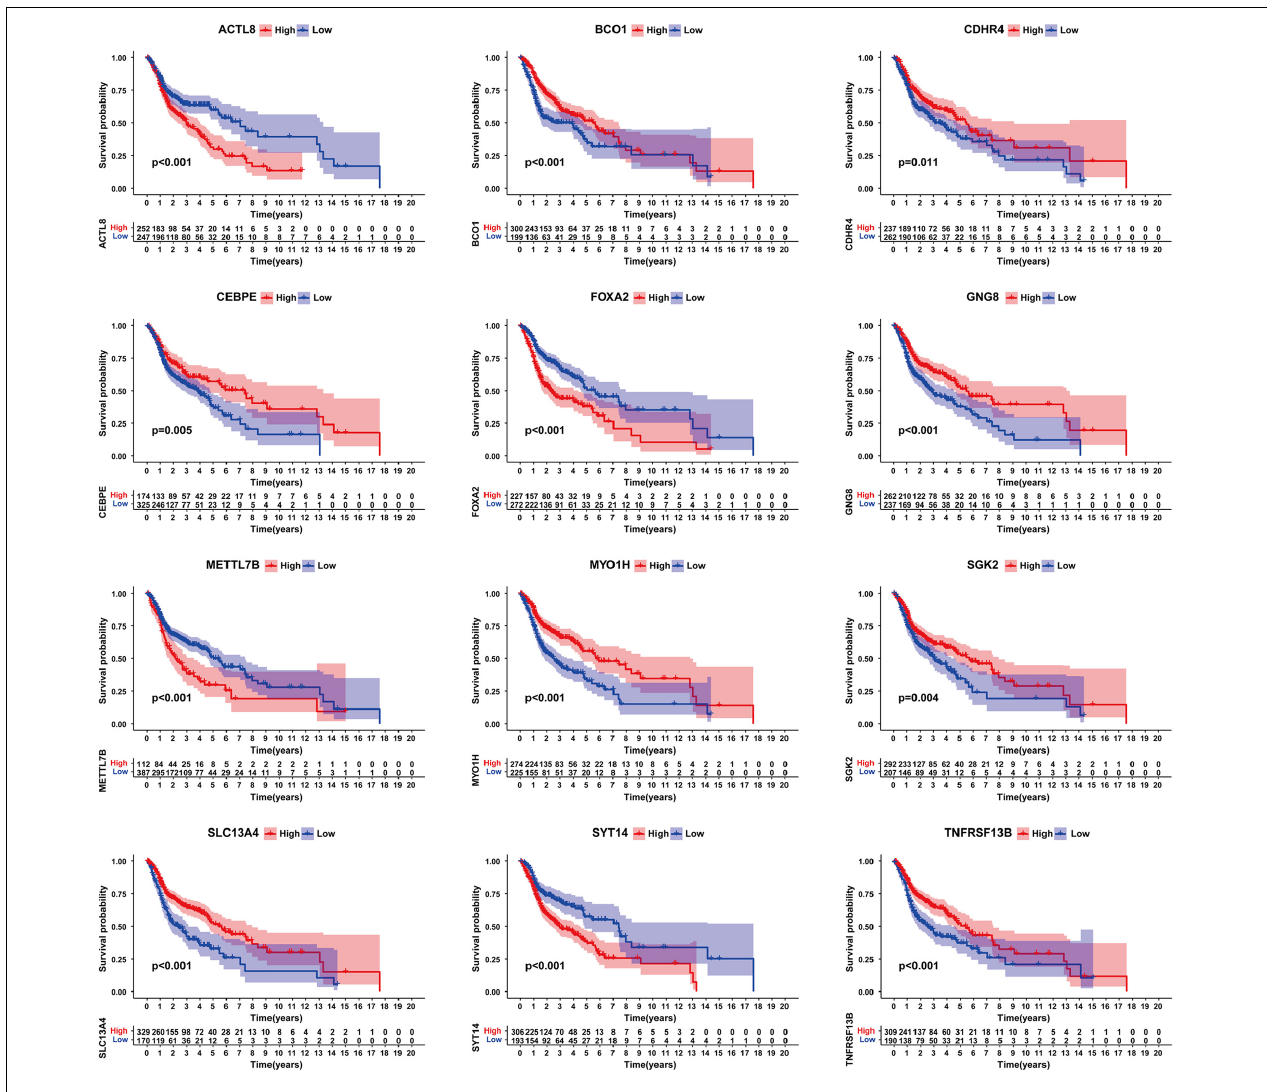
FIGURE 4 | Survival analysis of genes significantly related to survival. Including ACTL8, BCO1, CDHR4, CEBPE, FOXA2, GNG8, METTL7B, MYO1H, SGK2, SLC13A4, SYT14, and